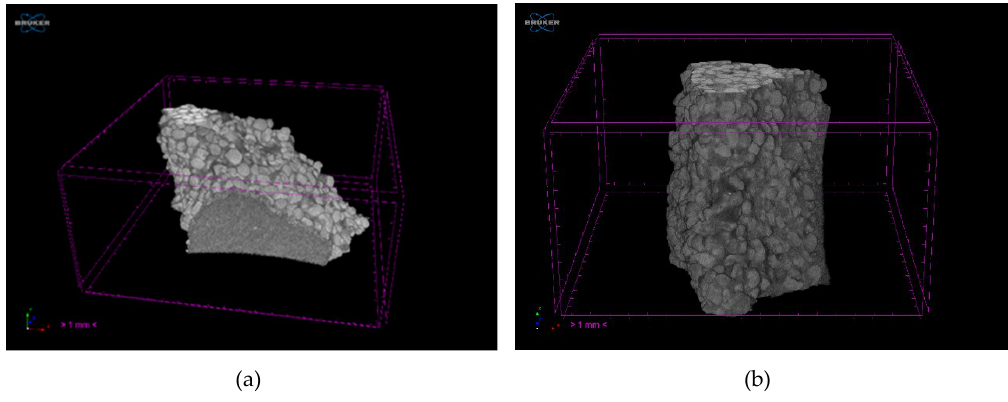
Figure 5. Three-dimensional reconstructions of the raw samples ( a ) Q1 and ( b ) Q2. Table 5 contains the porosity measurements and solid-phase percentage of the raw samples.